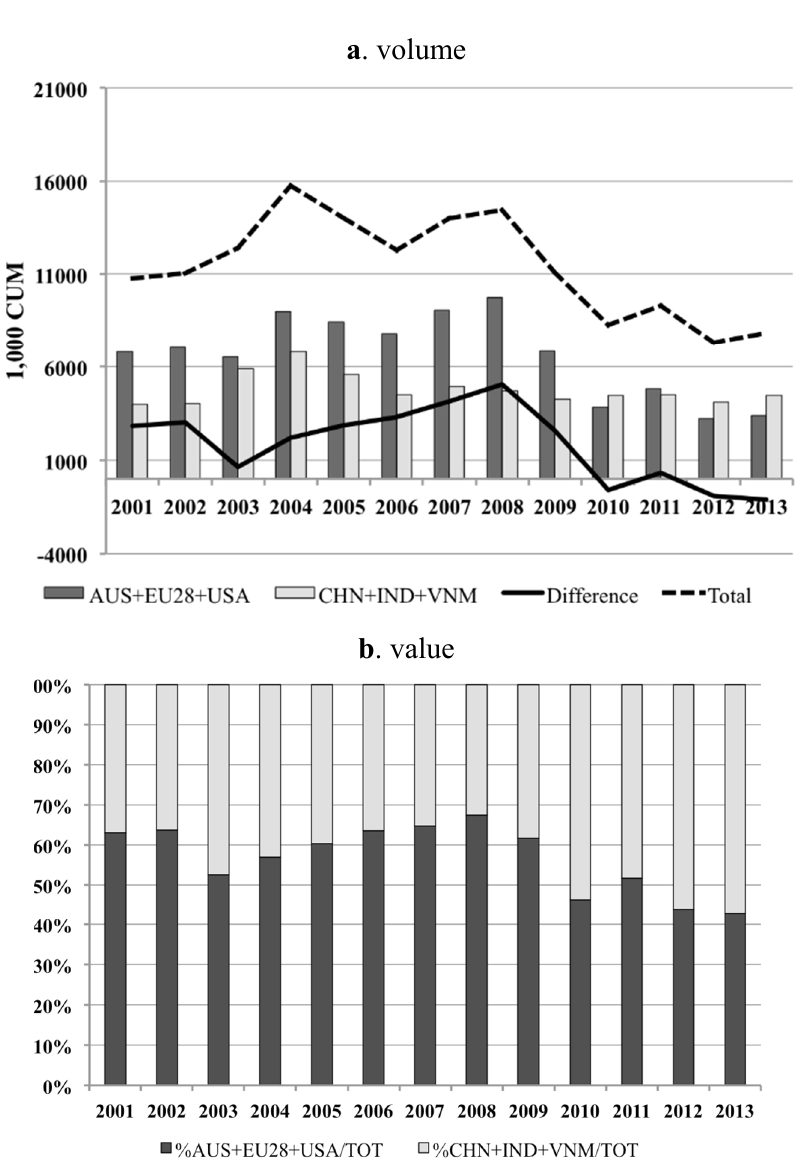
Figure B1. ( a ) Tropical timber product imports by groups of selected countries, in volume; and ( b ) % incidence of selected countries on total imports (2001–2013). AUS = Australia; CHN = China; EU-28 = European Union; IND = India; USA = United States of America; VNM = Vietnam. Difference means difference between (AUS + EU-28 + USA) and (CHN +IND + VNM). Source: own elaboration from